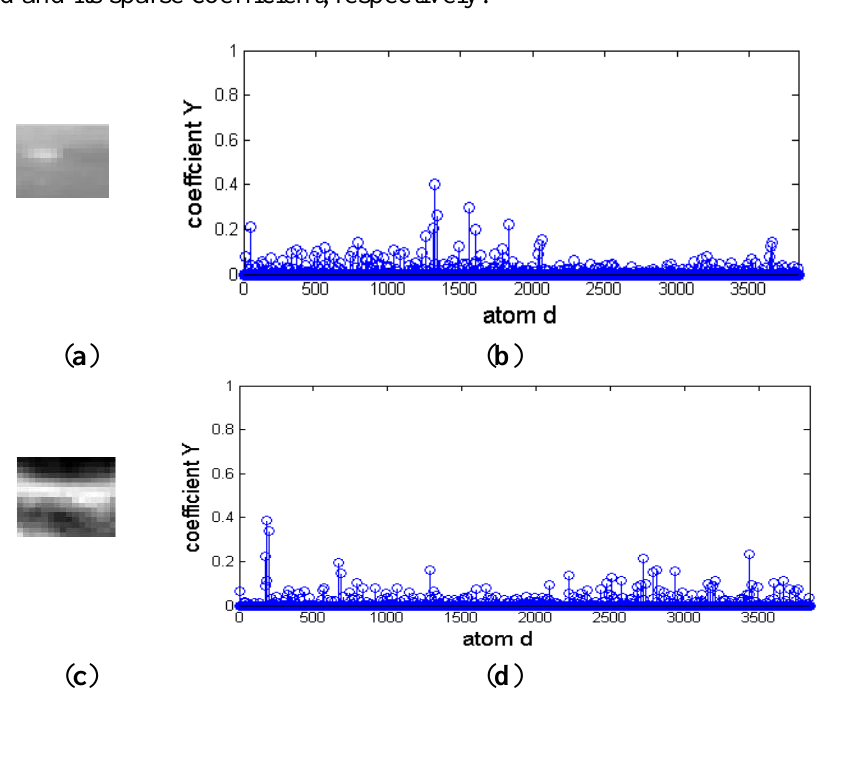
Figure 4. Representation coefficient of cloud image on Gaussian over-complete dictionary. ( a ) and ( b ) are target signal and it sparse coefficient, respectively. ( c ) and ( d ) are cloud background and its sparse coefficient,